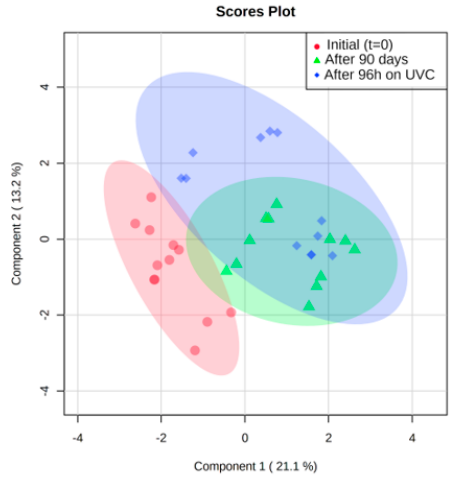
6 of 11 Figure 2. 1 H-NMR spectra obtained at 9.4 T (400 MHz for 1H) under initial conditions ( t = 0) for TAA Dama cultivar. To discriminate the variables (metabolites) that have the greatest impact on grain composition under the different darkening conditions addressed, classification models